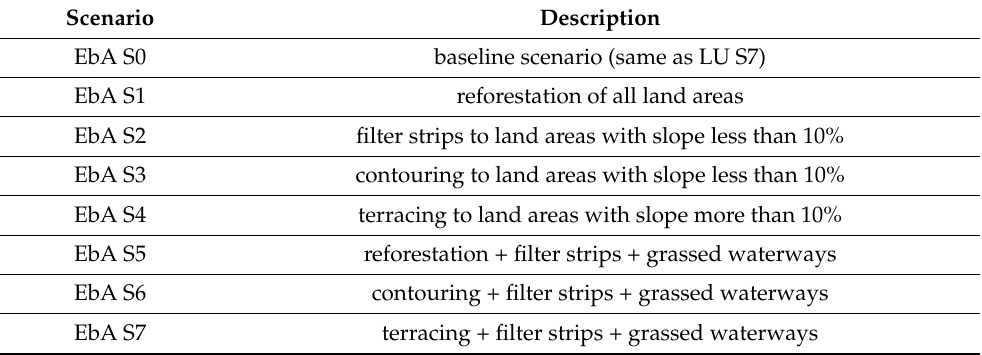
Table 4. Description of EbA